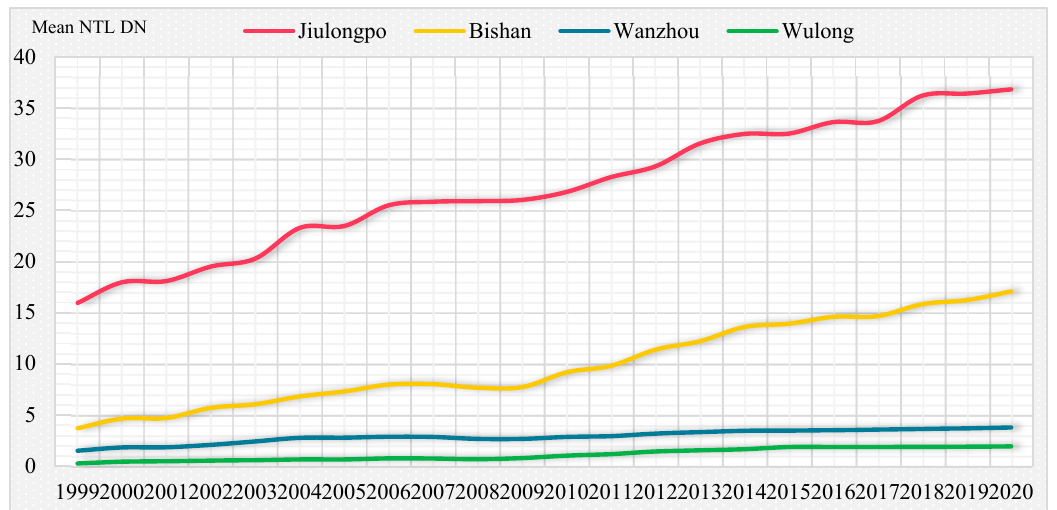
Figure 15. NTL mean from 1999 to 2020 for four suburban district zones.